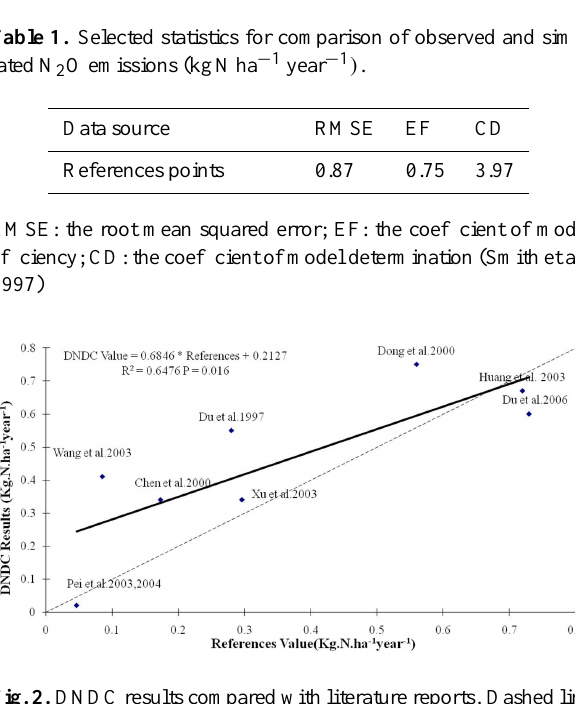
Fig. 2. DNDC results compared with literature reports. Dashed line is 1:1 line.